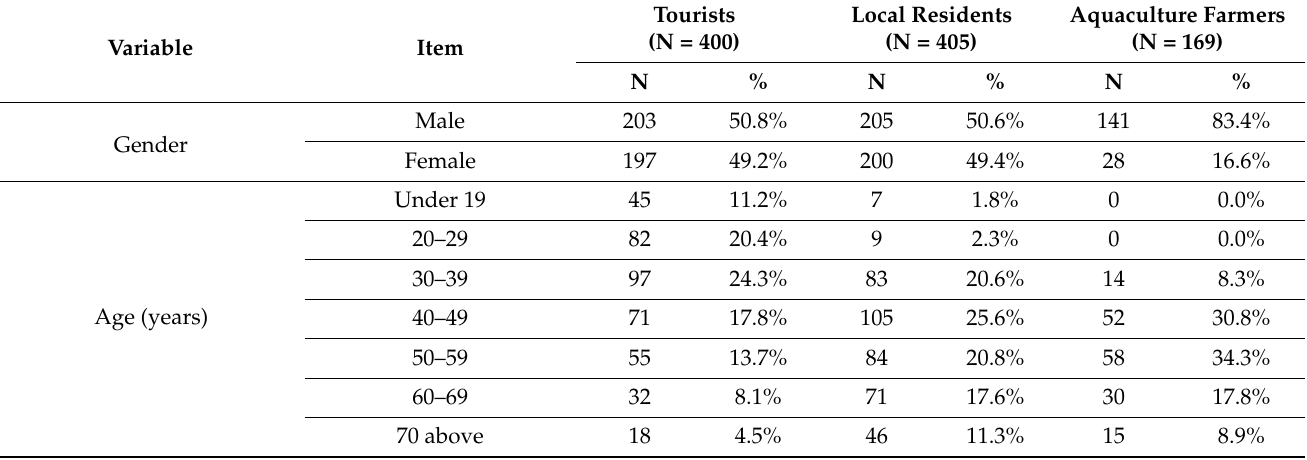
Table 3. Demographic